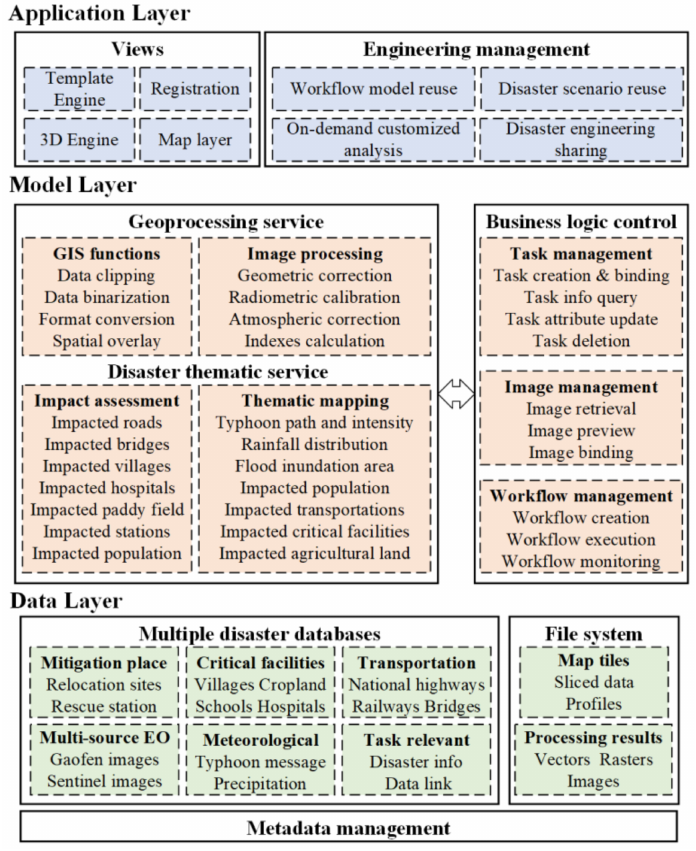
Figure 2. Architecture of Remote-sensing-based Disaster Decision Support System